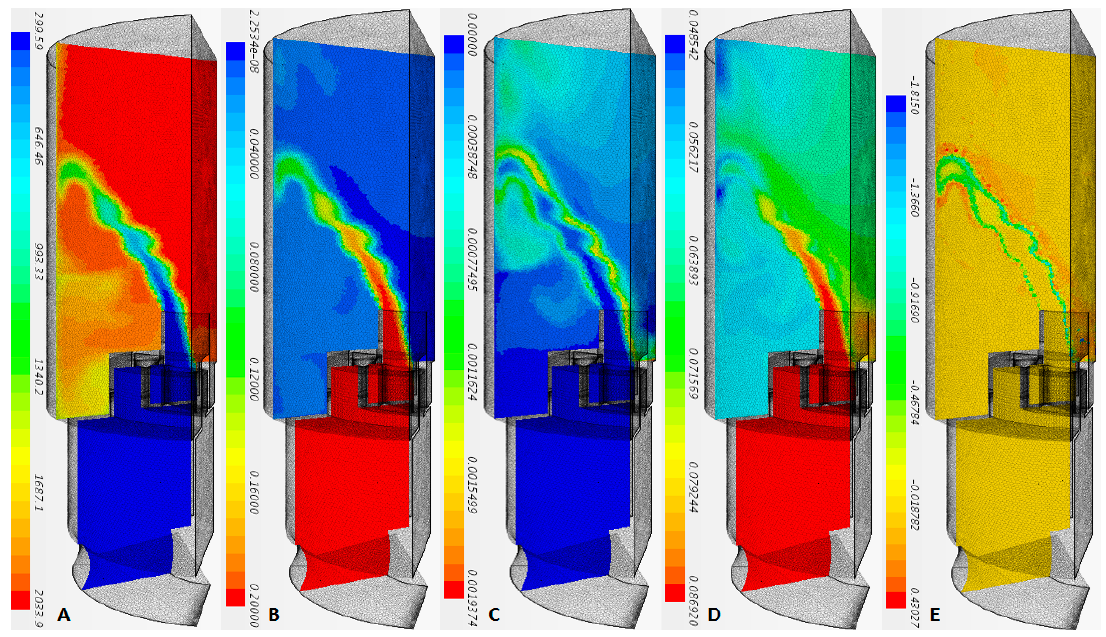
Figure 5. ( A ) Temperature (K); ( B ) ammonia concentration (mol%); ( C ) NO concentration (mol%); ( D ) hydrogen concentration (mol%); ( E ) hydrogen rate of production (kg/m 3 ·s). Operating conditions: 101 kPa, 304 K.